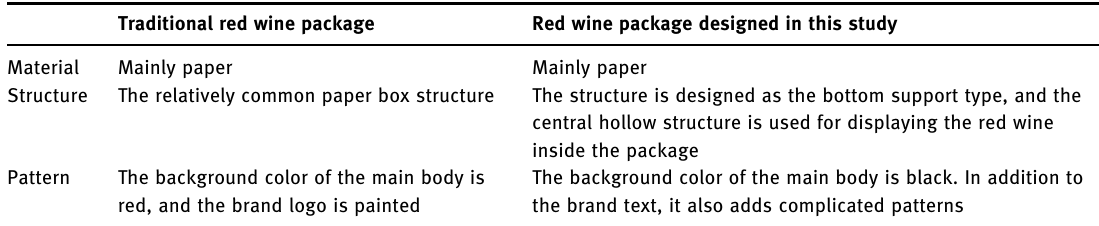
Table 1: Comparison between the traditional red wine package and the package designed in this study Traditional red wine